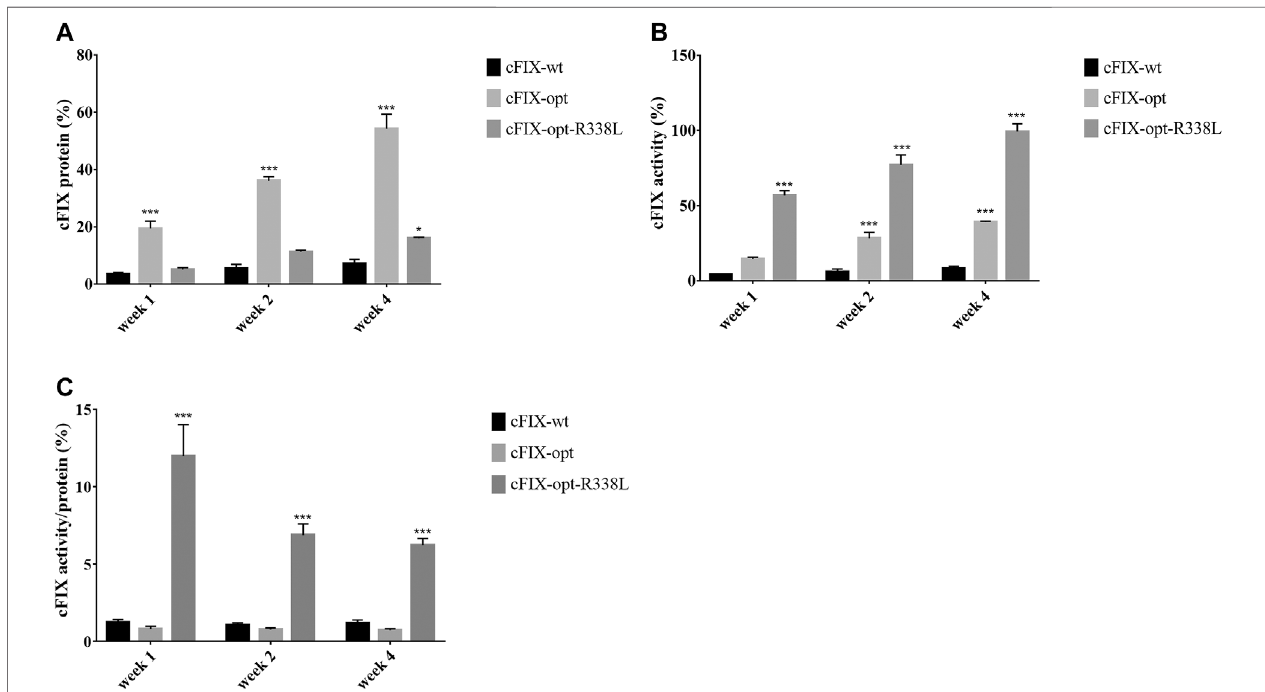
FIGURE 2 | Examine optimized cFIX mutant cassette in hemophilia B mice. Mice with FIX de fi ciency received 1 × 10 10 particles of scAAV8/cFIX-wt, scAAV8/cFIX- opt orscAAV8/cFIX-opt-R338L vectors( n =4). Bloodwascollectedfromtheretro-orbitalvenousplexusatweeks 1,twoand 4. (A) canineFIX concentrationsinplasma were detected by ELISA. (B) cFIX activities were measured by aPTT assay. The ratio of cFIX protein to activity was calculated and shown in (C) *** p < .001, * p < .05.